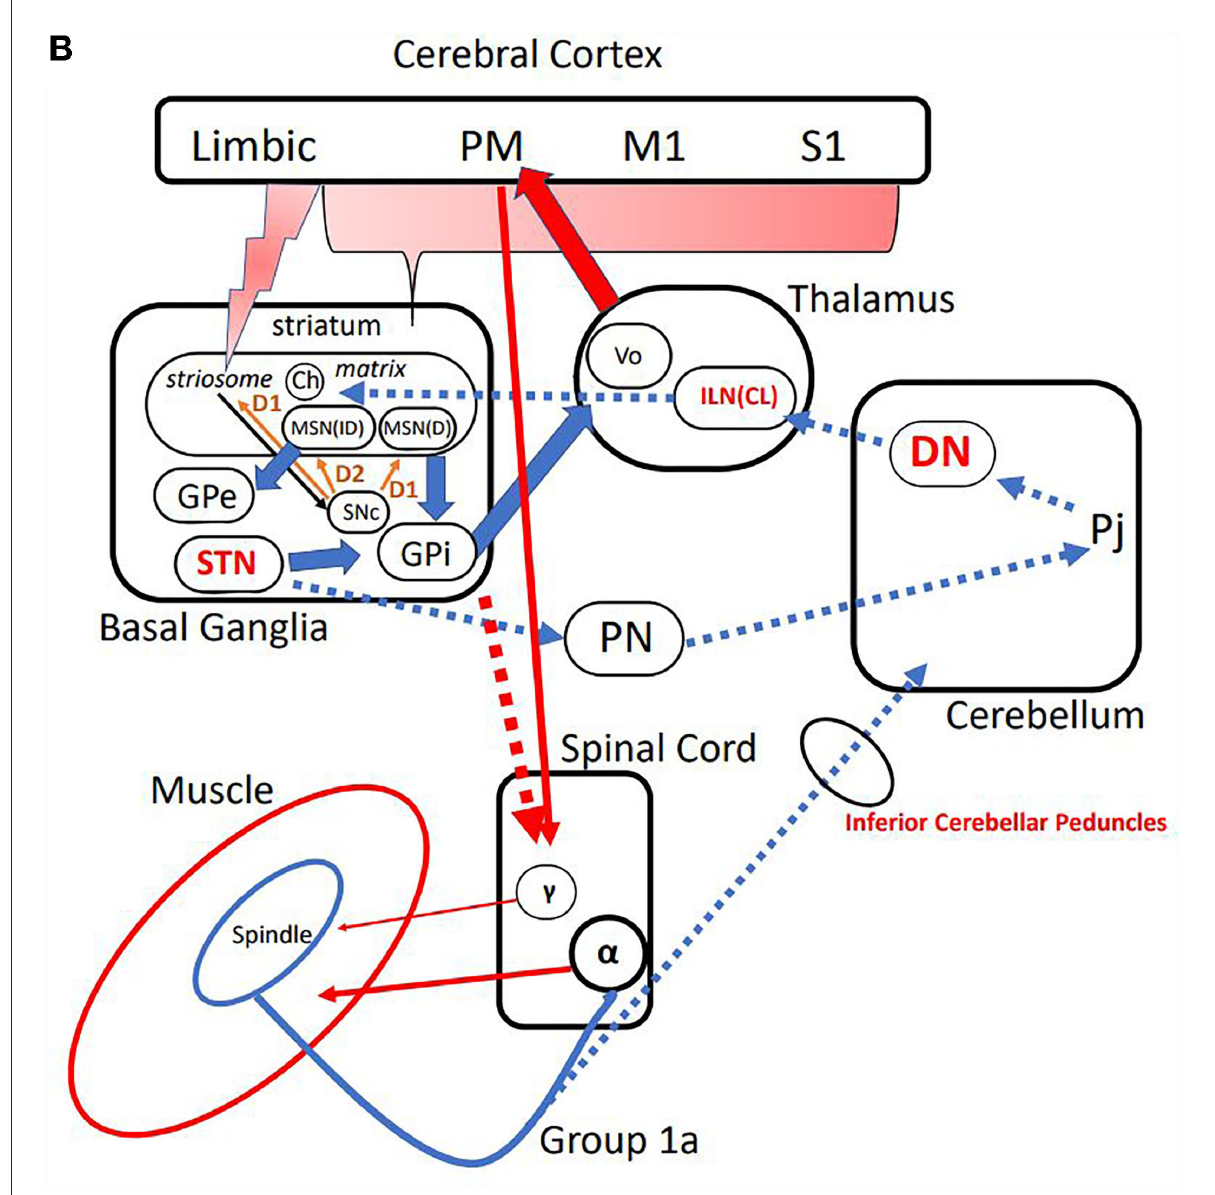
FIGURE1 (A) Classical model of basal ganglia [Alexander and Crutcher (23)]. Left: Normal condition depicting “excitatory” direct and “inhibitory” indirect pathways. The majority is the inhibitory indirect path, which constitutes “surround inhibition” around the direct path activity of allowing activation of selected muscles. Open arrows are excitatory glutamatergic, and closed arrows are inhibitory GABAergic projections. Dopaminergic projections terminate on medium spiny neurons (MSNs) with excitatory D1 receptor on the direct, and inhibitory D2 receptor on the indirect pathways. Right: Suggested model in dystonia. Relative excess of dopamine from SNc produces direct pathway predominance, and disintegrates surround inhibition. Putative sites of action of DBS are shown with red arrows. SNc, Substantia Nigra pars compacta; GPe, Globus Pallidus externus; STN, Subthalamic Nucleus; GPi, Globus Pallidus internus; Thal, Thalamus. (B) Pathways proposed in the pathogenesis of dystonia and TVR-induced dystonic movements. Cerebral Cortex: PM premotor area, M1 primary motor area, S1 primary somatosensory area. Basal Ganglia: Ch cholinergic interneurons, MSN(D) medium spiny neuron in direct pathway, MSN(ID) medium spiny neuron in indirect pathway. Thalamus: Vo thalamic ventral-oralis complex, ILN(CL) intralaminar nuclei in primates or centro-lateral nucleus in rodents. Cerebellum: DN dentate nucleus, Pj Purkinje cells. PN, pontine nuclei. Spinal Cord: α - α motoneuron, γ - γ motoneuron. Broken arrows are putative pathway mediating TVR-induced movements, and possible targets are shown in